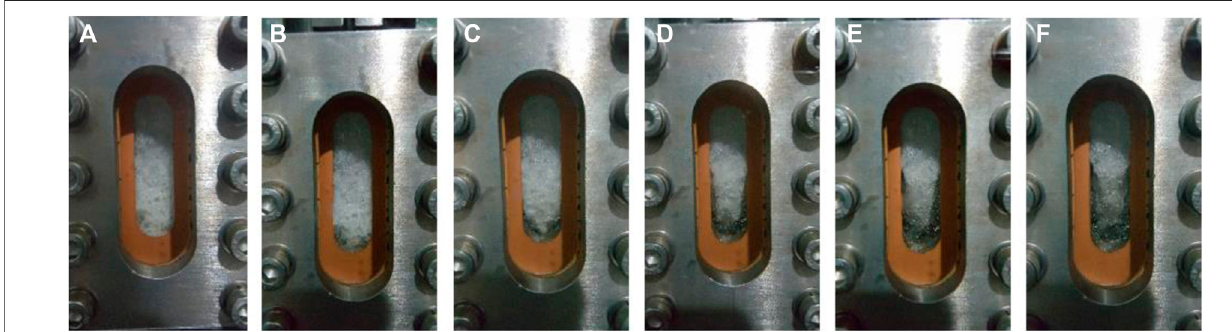
FIGURE 5 | The captured pictures during Experiment 5.